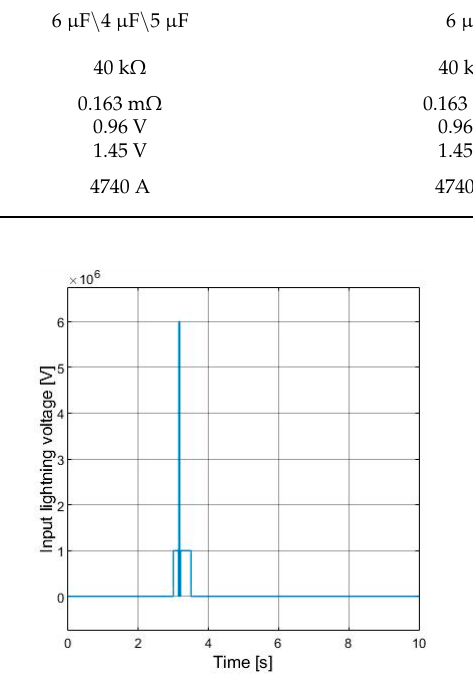
Figure 8. Input lightning voltage waveform.